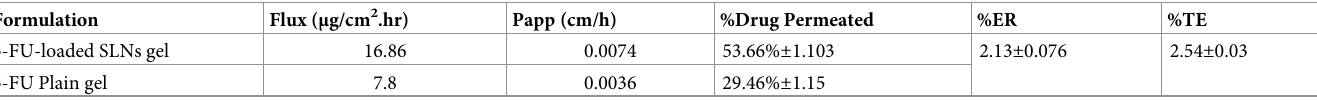
Table 3. Permeation analysis of 5-FU-loaded SLNs gel and 5-FU plain gel.